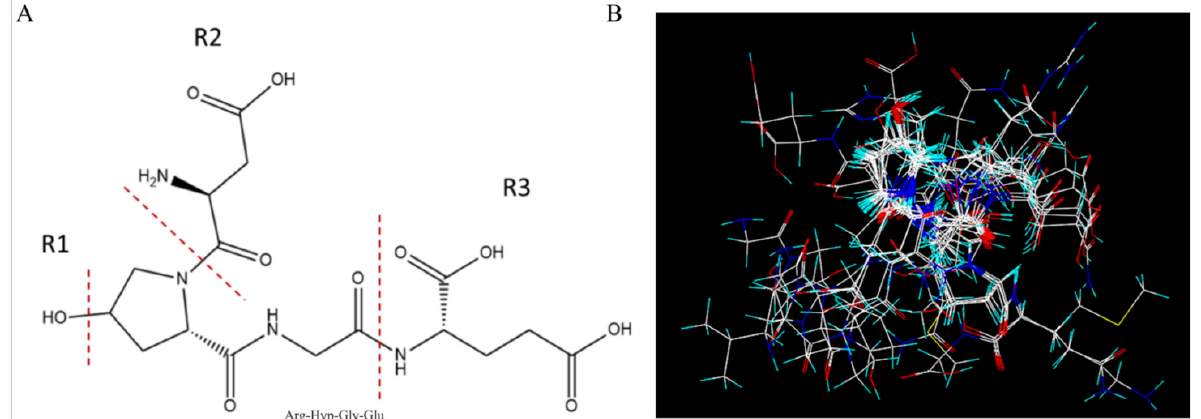
Figure 1. Establishment of 3D-QSAR model. ( A ) The common skeleton OG(PG) and R1, R2, R3 groups. ( B ) Molecular alignment of 23 antiplatelet